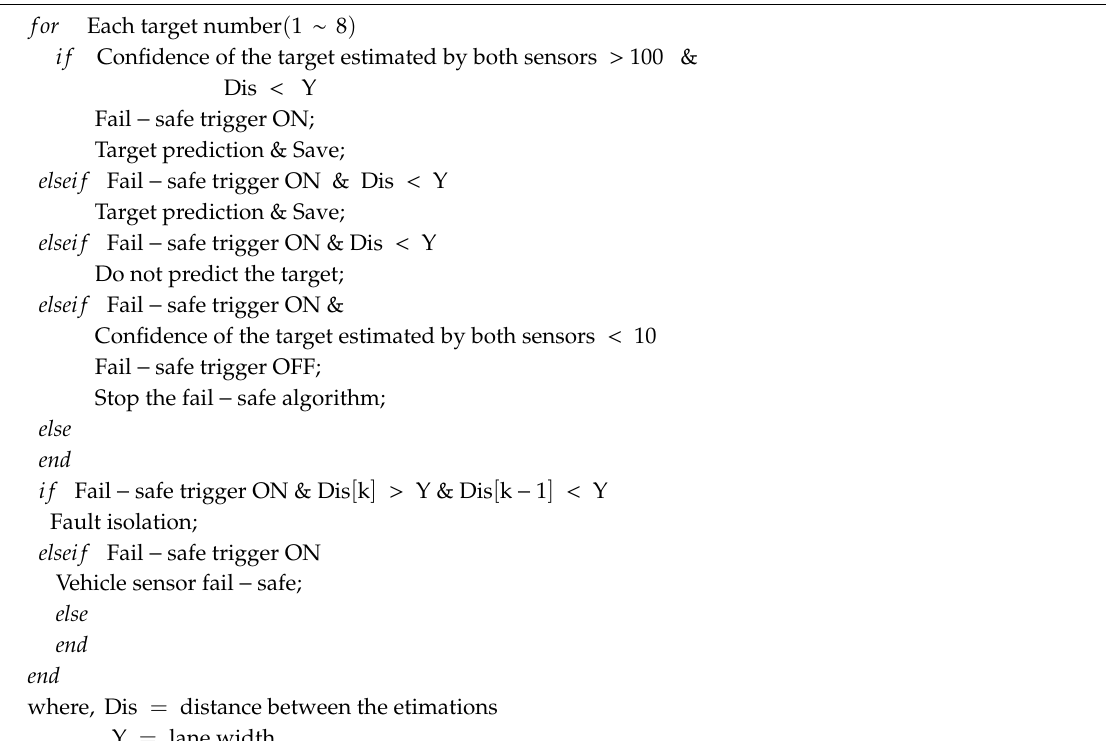
Algorithm 1 Online algorithm of exteroceptive sensor fail-safe